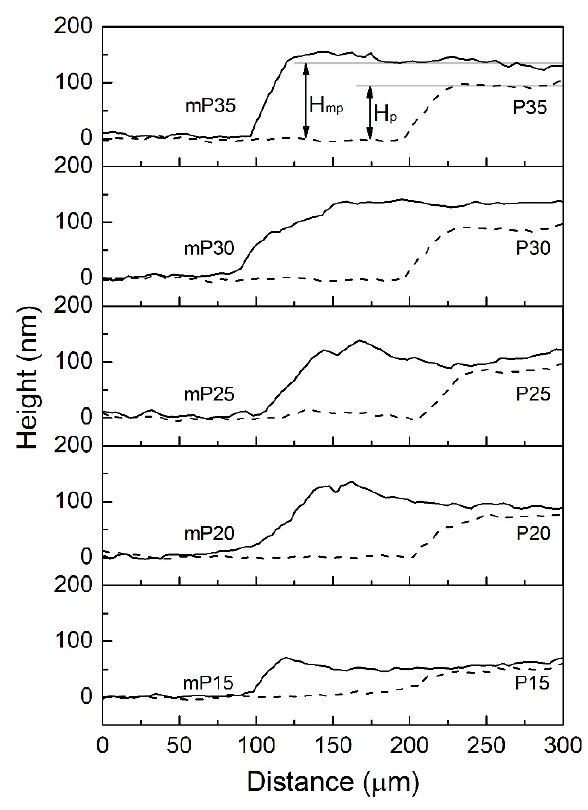
Figure 2. Thickness of the mPEDOT and PEDOT thin films.